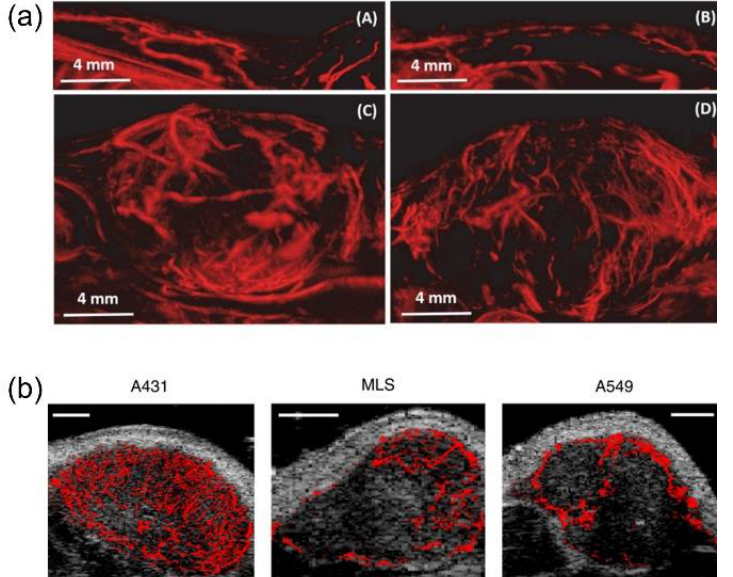
Figure 5. Representative SRU images of microvasculature in tumor-bearing tissues. ( a ) Maximum intensity projections of 3D SRU imaging on healthy rats (upper panel), and tumor-bearing rats (lower panel). (Reprinted with permission from Ref. [67]. Copyright 2017 Ivyspring International Publisher) ( b ) SRU imaging of tumors with different vascular phenotypes. (Reprinted with permission from Ref. [68]. Copyright 2018 Springer Nature).